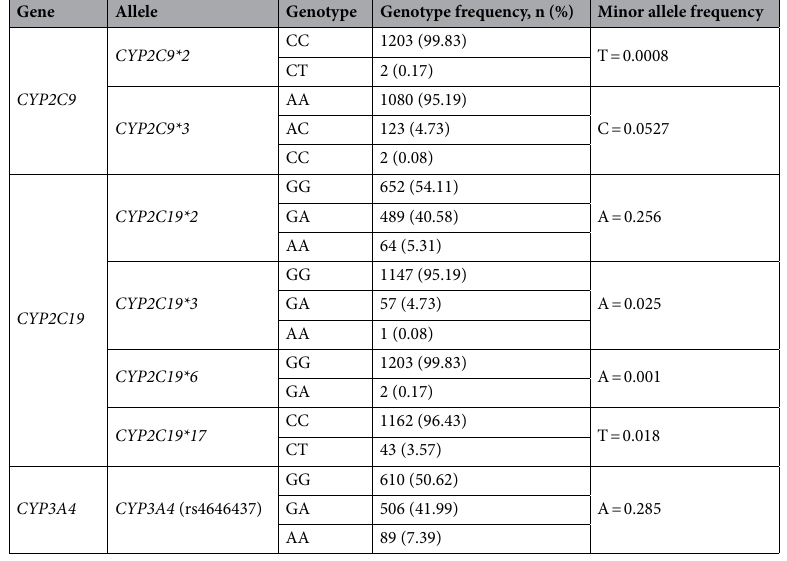
Table 2. Genotype and allele frequencies of CYP2C9 , CYP2C19 , and CYP3A4 polymorphism in a Thai population (n =